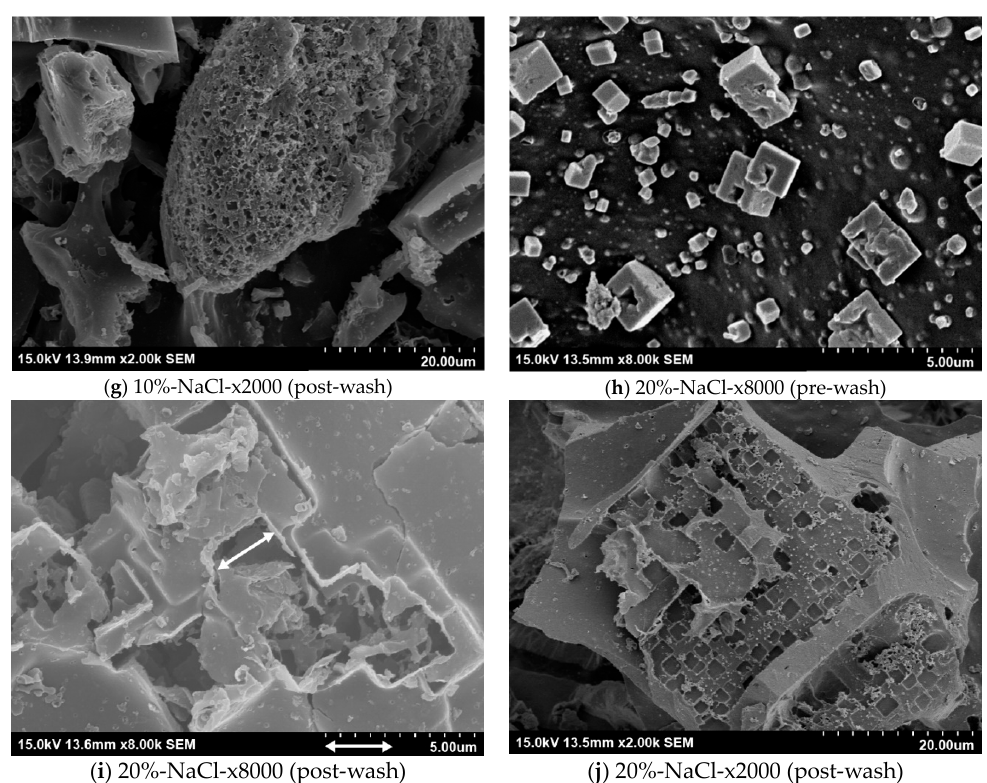
Figure 2. ( a – j ) scanning electron microscopy (SEM) images of biochar samples with different NaCl